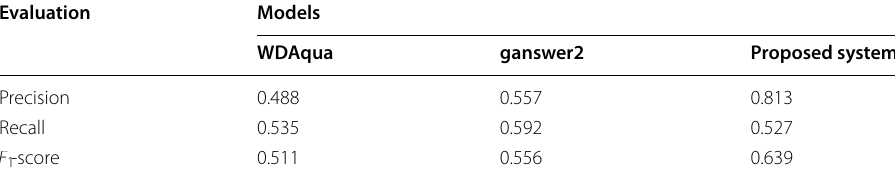
Table 6 End-to-end performance on the QALD-7 dataset